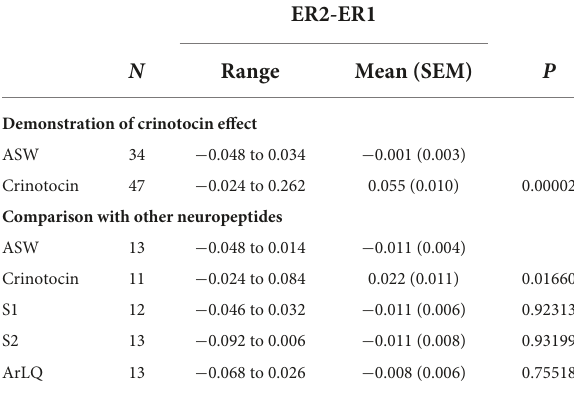
TABLE 1 Response of Antedon mediterranea arm preparations to crinotocin and other